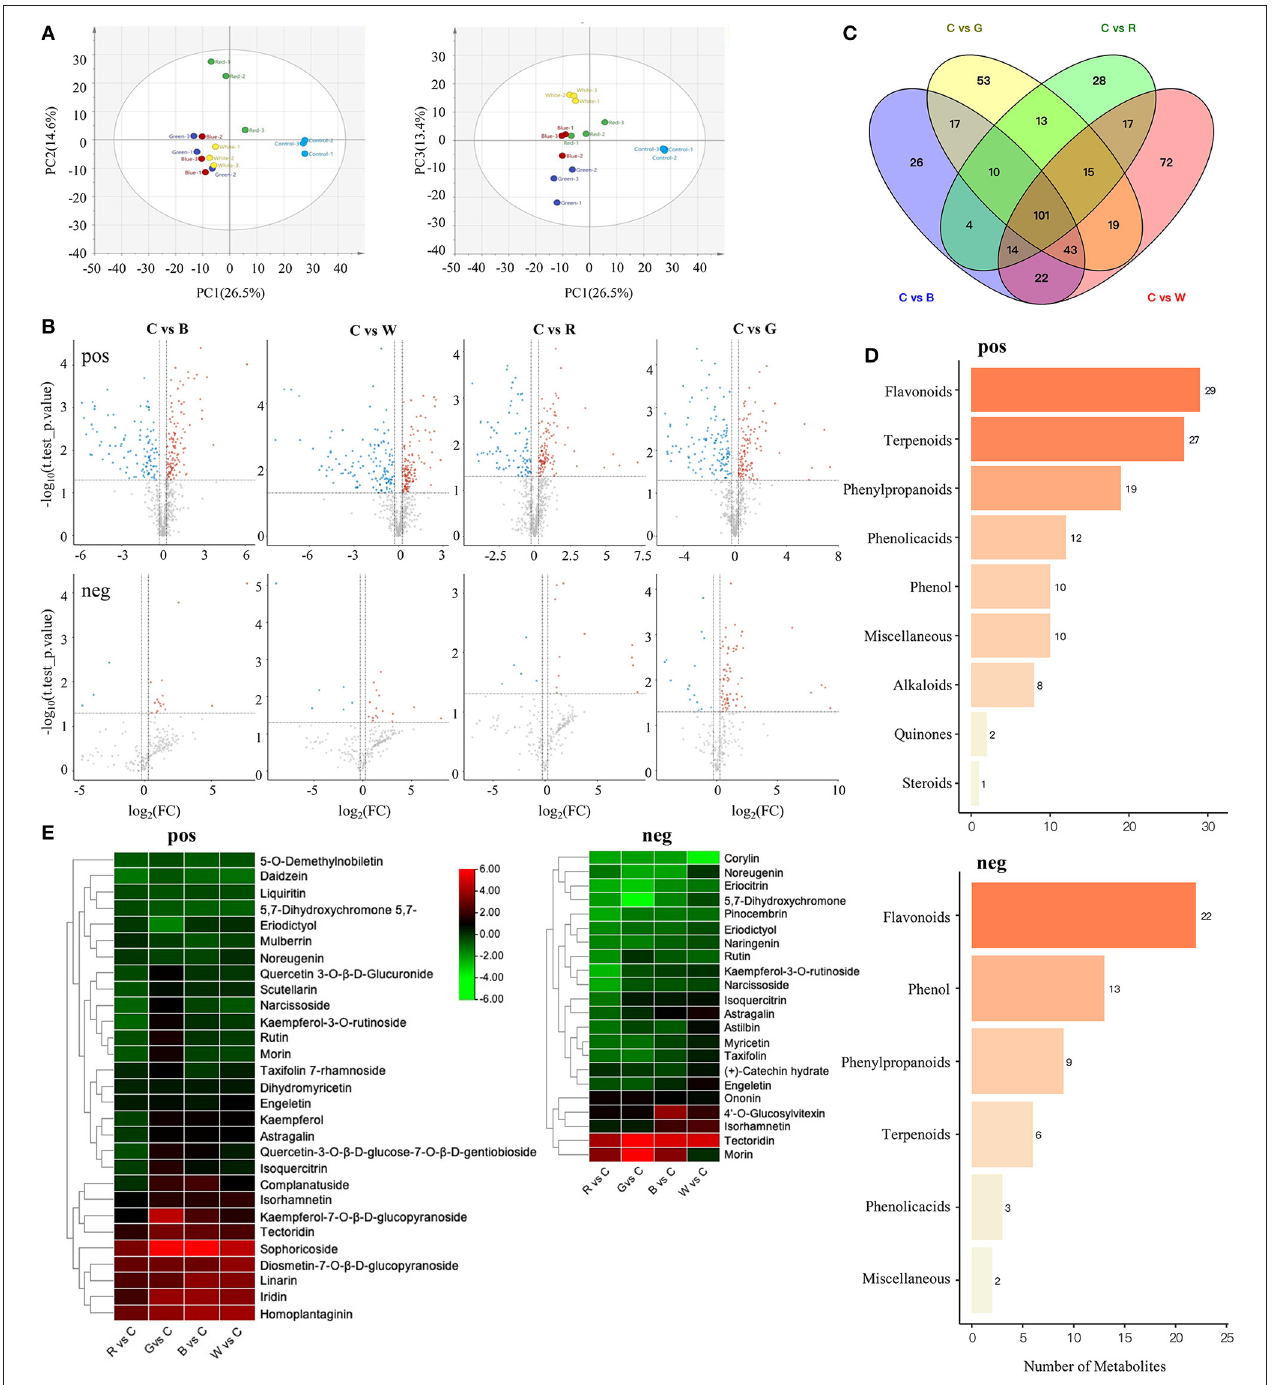
FIGURE 2 | Analyze the metabonomic data of grape berries treated with different light quality. (A) PCA score plot metabolite profiles from different treatment groups. (B) Volcano plots of significantly changed metabolites (SCMs) between C vs. B, C vs. G, C vs. R, and C vs. W. The first line is pos mode, the second line is neg mode. (C) Venn diagram of SCMs. (D) KEGG classification of the measured pos and neg metabolites. (E) Cluster heatmap of flavonoids and anthocyanins between C vs. R, C vs. G, C vs. B, and C vs. W. C: control (no light treatment), B: blue light treatment, R: red light treatment, W: white light treatment, G: green light treatment, pos: positive mode, neg: negative